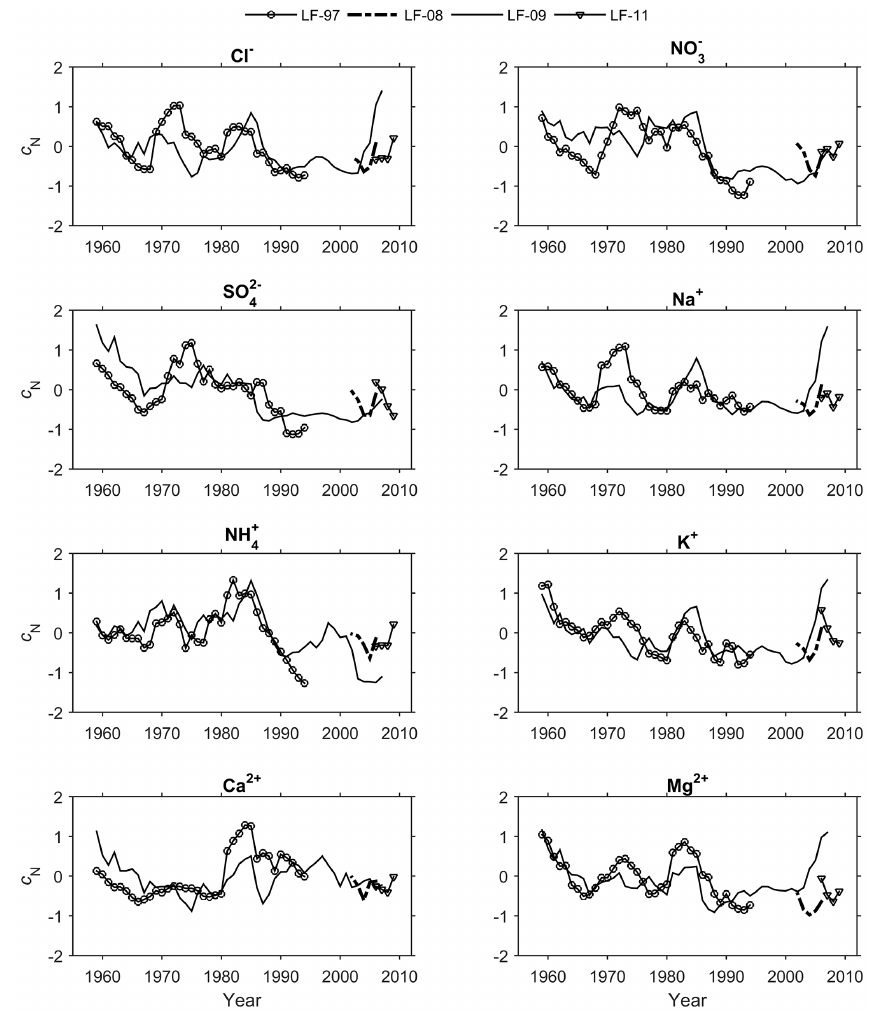
Figure 2. Comparison of normalized ionic concentrations ( c N ) in the different LF-ice cores using a 5-year moving